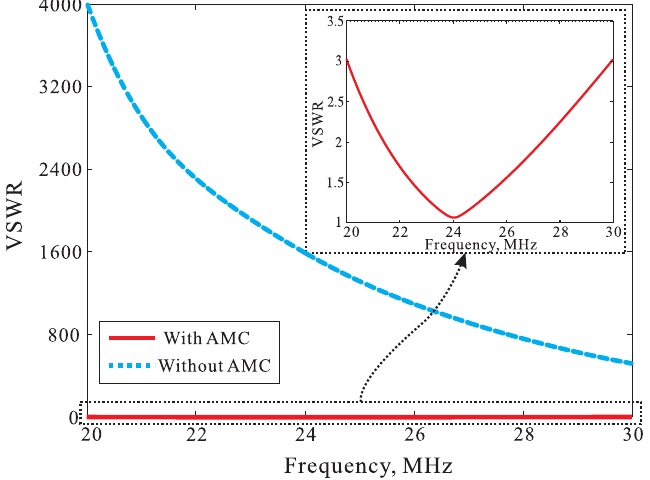
Figure 8. Simulated VSWRs of the proposed antenna with and without of the AMC. Simulated radiation patterns of the proposed antenna with the AMC at 20 MHz,